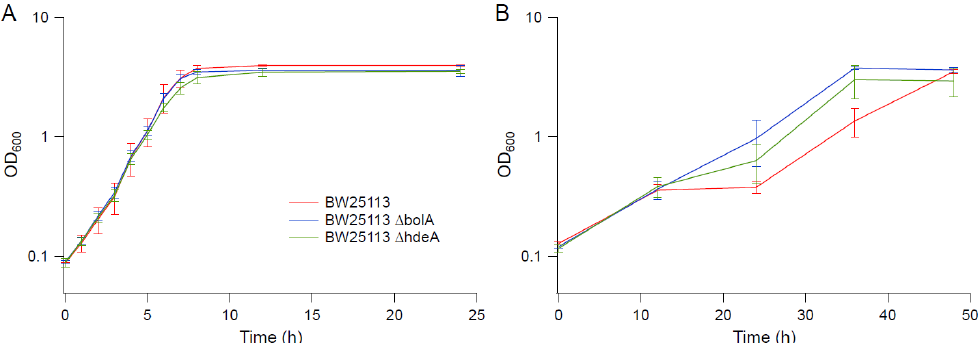
Figure 9. Growth kinetics of knockout strains in BW25113 background. ( A ) M9. ( B ) M9 supplemented with 0.6 M NaCl. Error bars are standard deviations.